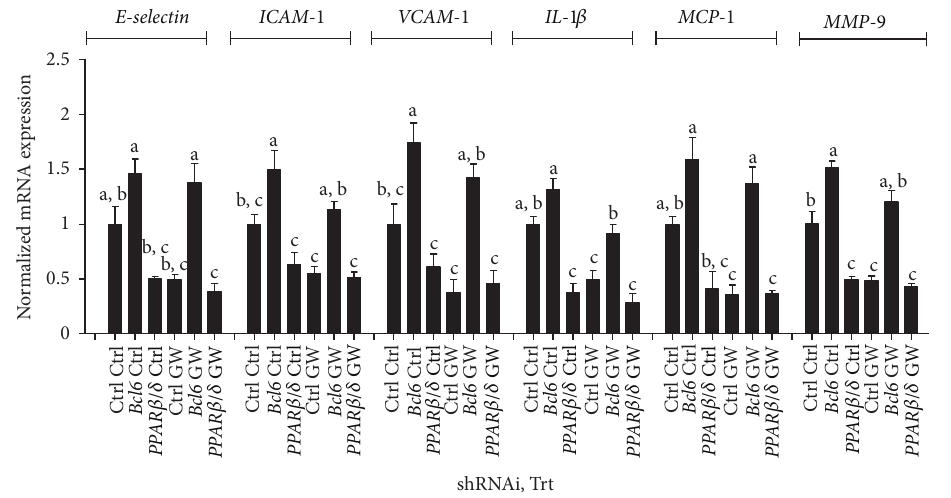
Figure 3: Effects of 𝑃𝑃𝐴𝑅𝛽/𝛿 and BCL-6 knockdown on Miapaca-2 gene expression. Miapaca-2 cells were transiently infected with nontargeting control, hBCL-6 or ℎ𝑃𝑃𝐴𝑅𝛽/𝛿 - specific shRNAs and then stimulated with human 𝑇𝑁𝐹𝛼 with or without GW501516 for 24 hours. Total mRNA was isolated and gene expression was determined using qRT-PCR. Data is normalized to 𝛽 -actin and indicated as fold